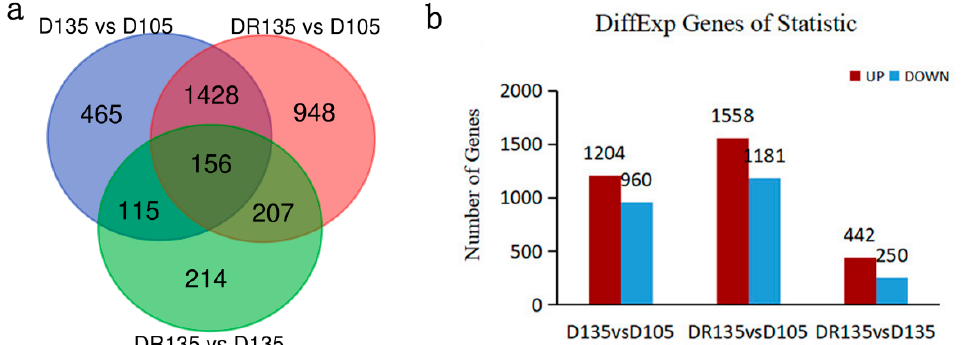
Figure 3. Summary of DEGs. ( a ) Venn diagram illustrating the overlaps of DEGs between D135 vs. D105, DR135 vs. D105 and DR135 vs. D135. ( b ) Number of up-regulated and down-regulated expression genes between D135 vs. D105, DR135 vs. D105, and DR135 vs. D135. The x-axis represents the comparison scheme between the indicated different time points. The y-axis represents the corresponding number of DEGs. The red columns represent up-regulated expression genes and blue columns represent down-regulated expression genes.